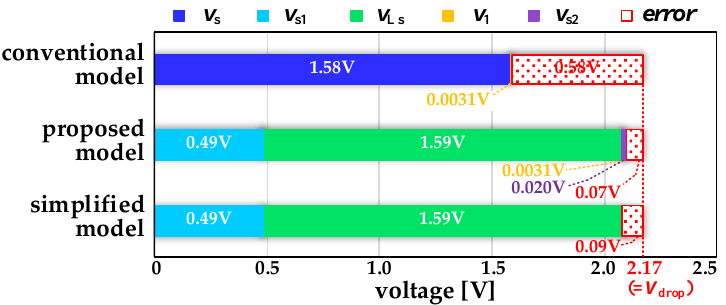
Figure 8. Impedance voltage ratio of voltage drop according to equivalent circuit models.